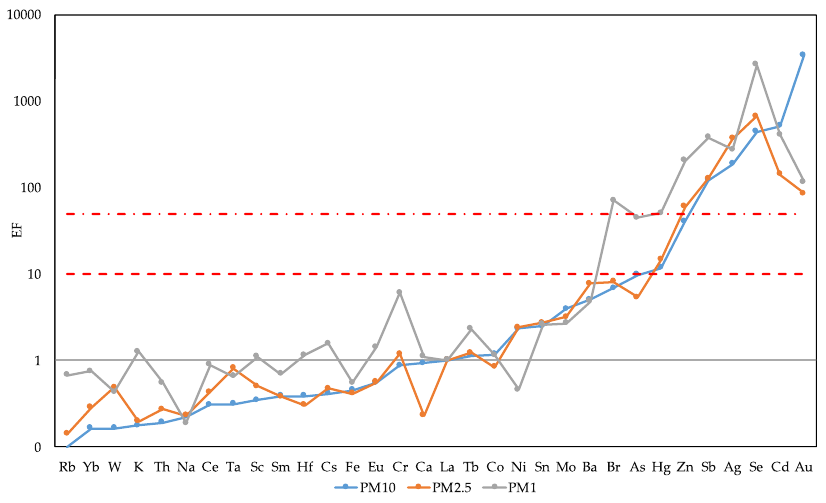
Figure 2. Enrichment Factors of all the elements investigated in this study in the three PM fractions. La was used as the normalized agent.